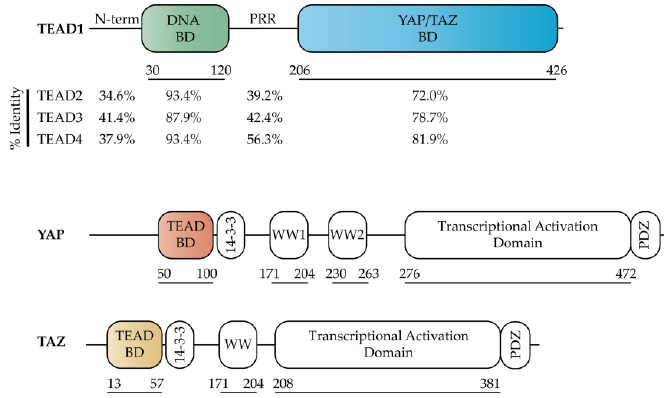
Figure 2. Domain organization of Hippo transcription factors TEAD, YAP (isoform YAP1-2γ), and TAZ. The percent identity for individual domains of TEAD1–4 was calculated relative to TEAD1 using Clustal Omega [13].